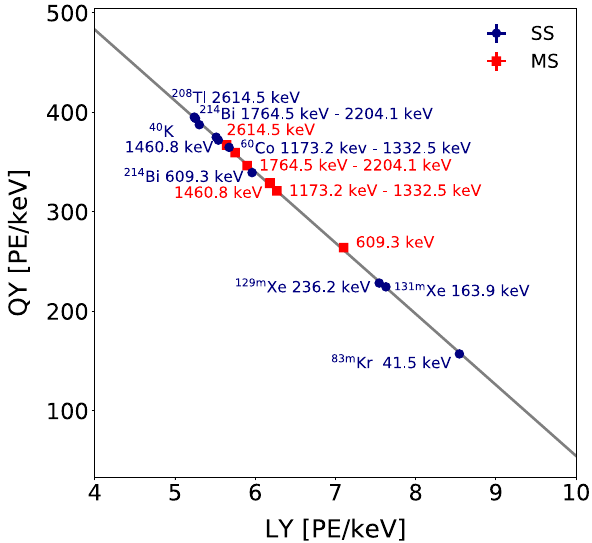
Fig. 5 Anti-correlation between the measured light yield (LY) and charge yield (QY) using mono-energetic lines. These data points are from SS (blue) and MS (red) events in the inner 1t fiducial volume. The values are different for SS and MS events at a given energy due to the energy-dependent ion-electron recombination processes. The best linear fit for combined SS and MS data points is overlaid as a solid line